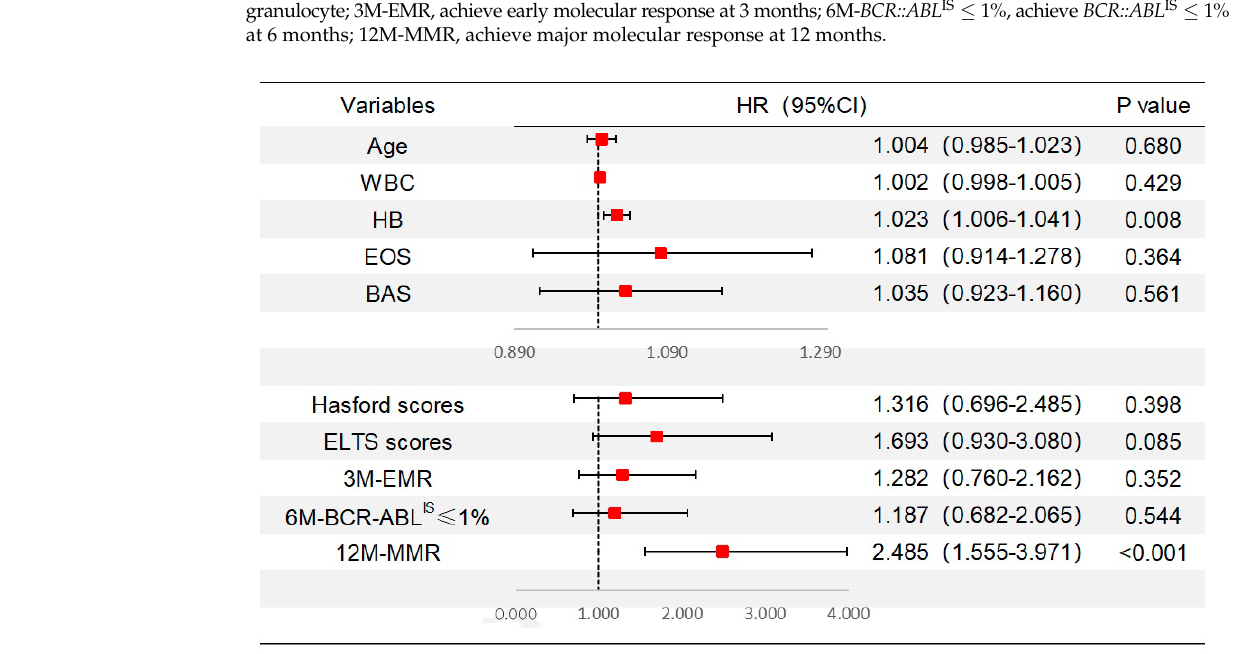
Figure 5. Multivariate analysis on achieving MR 4.5